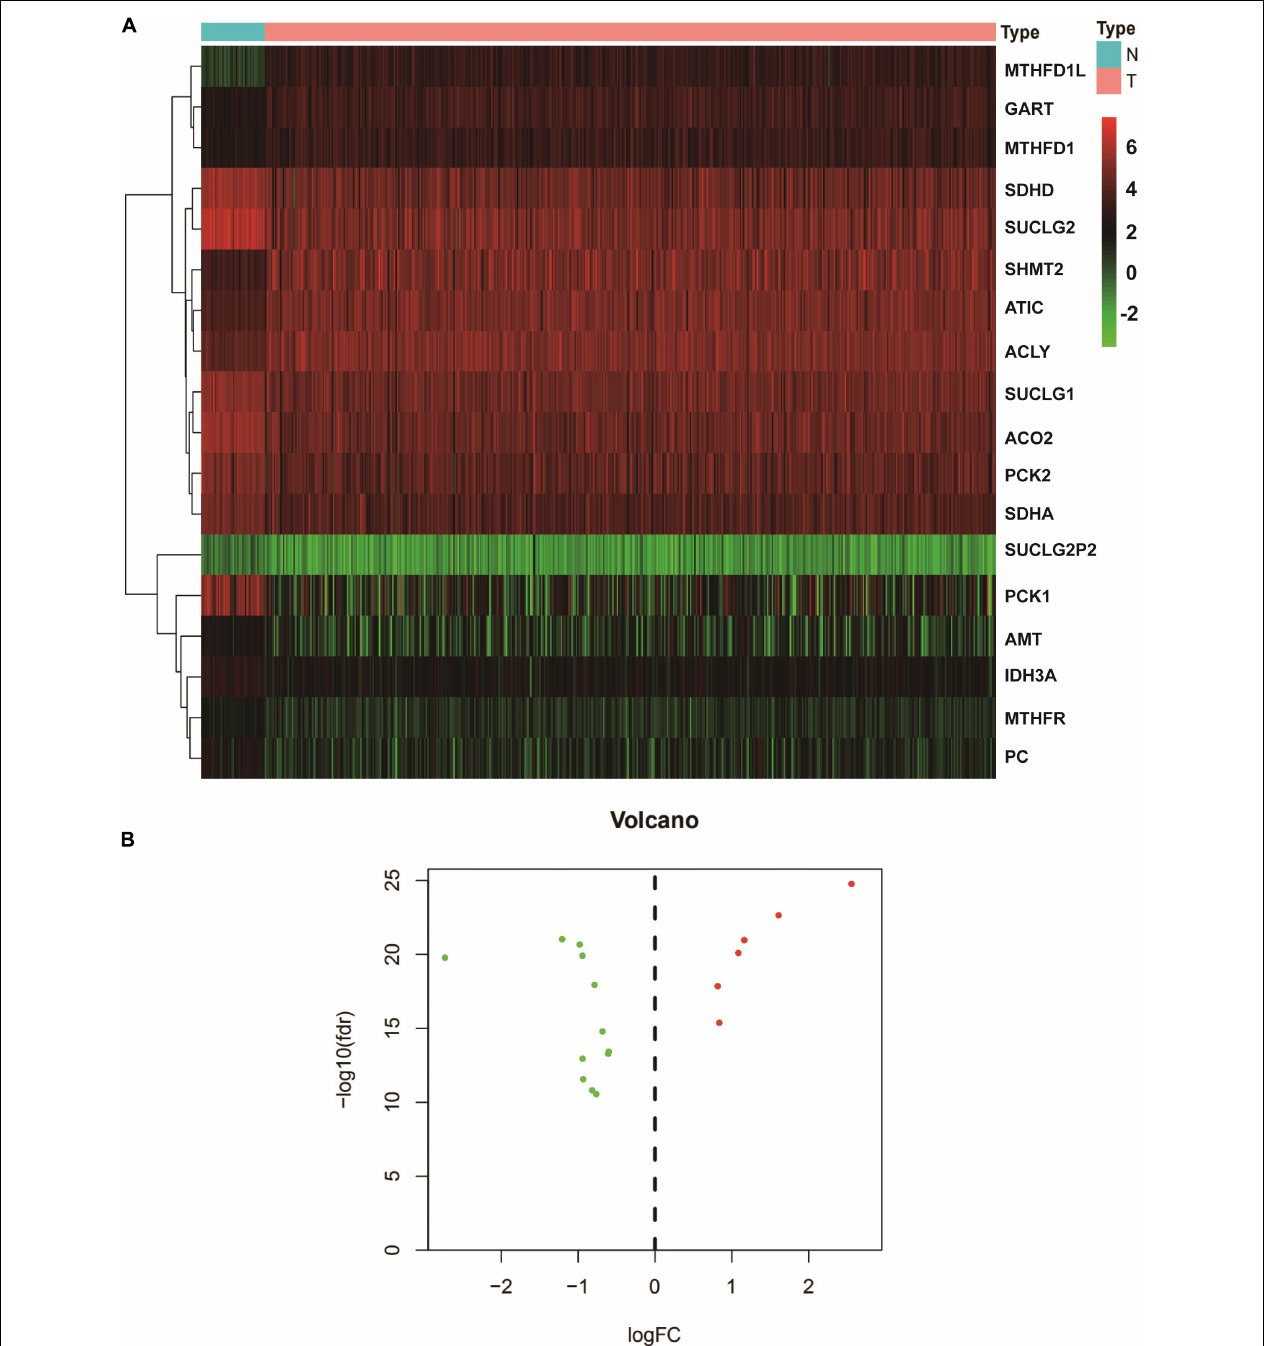
FIGURE 1 | Identification of DEGs in the TCA and one carbon metabolism pathway from TCGA datasets. (A) The heatmap of DEGs in COAD. From red to green, the expression of genes decreased gradually. (B) Volcano plot of DEGs. The green represented the down-regulated genes, red represented up-regulated genes. N, normal; T, tumor. DEGs, Differentially expressed genes; COAD, Colon